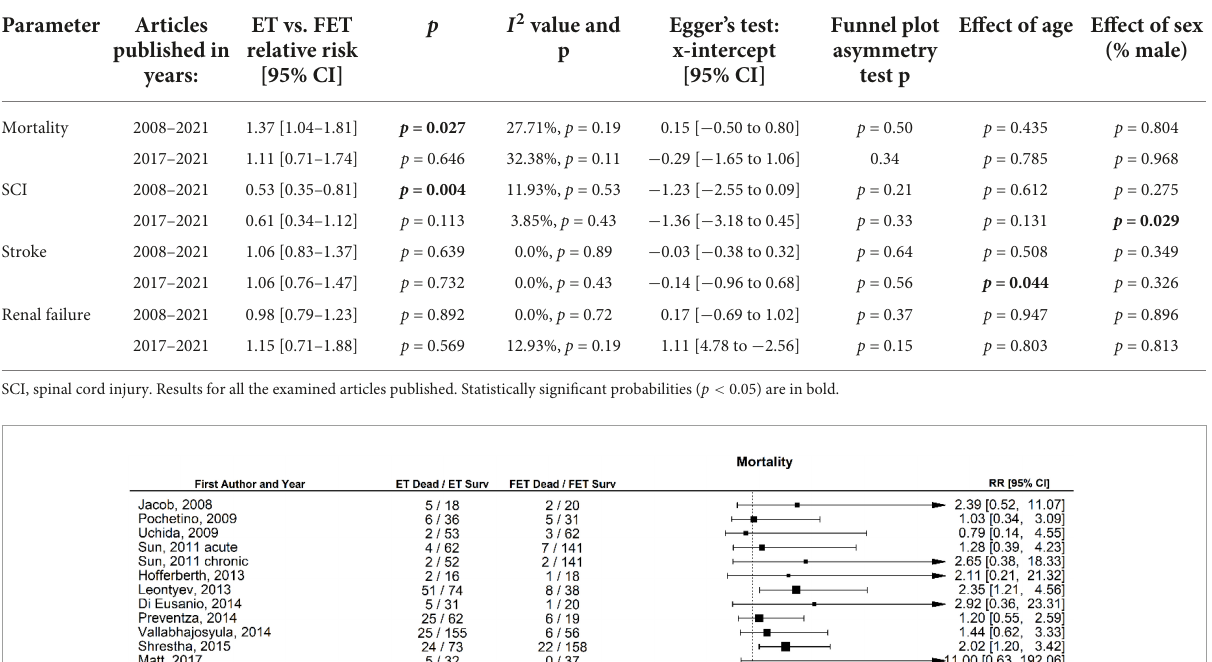
TABLE 3 Elephant trunk (ET) vs frozen elephant trunk (FET) odds ratios and 95% confidence intervals (CI) and probability (p) of effects of age and sex (% male patients).